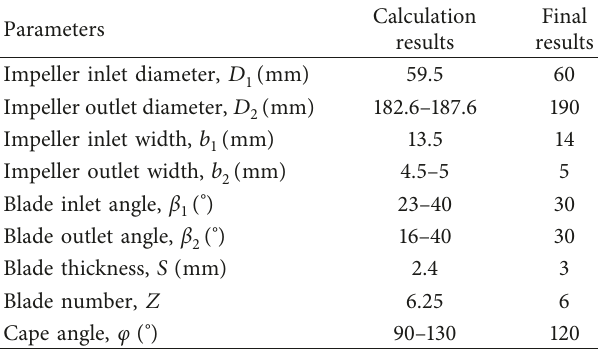
Table 1: The main structural parameters of the impeller.